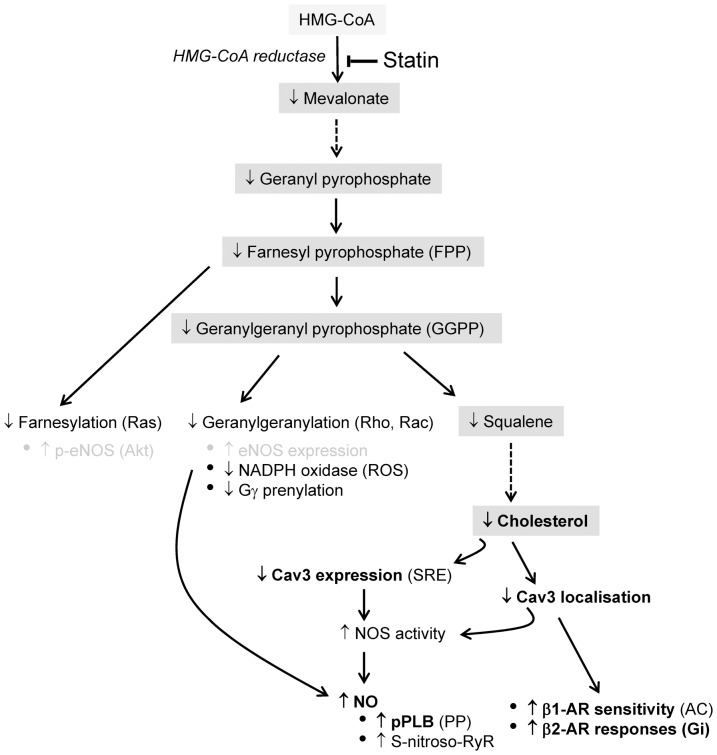
Statin effects on the cardiac myocyte.The main cholesterol synthesis pathway is highlighted in grey. The impact of statin inhibition of HMG-CoA reductase, the rate limiting step of cholesterol synthesis, is shown. Statins limit production of cholesterol and isoprenoid intermediates (FPP, GGPP). The latter are responsible for post-translational modification of a number of proteins including those of the small G protein family (Ras, Rho, Rac). The potential roles of isoprenoid- and cholesterol-dependent changes in modulating cardiac myocyte function are listed. From the present study, bold text indicates established effects, whereas grey text denotes effects which have been eliminated. ROS reactive oxygen species (which reduce bioavailable NO); PP phosphatase; AC adenylyl cyclase. See Discussion for detailed mechanisms and references.